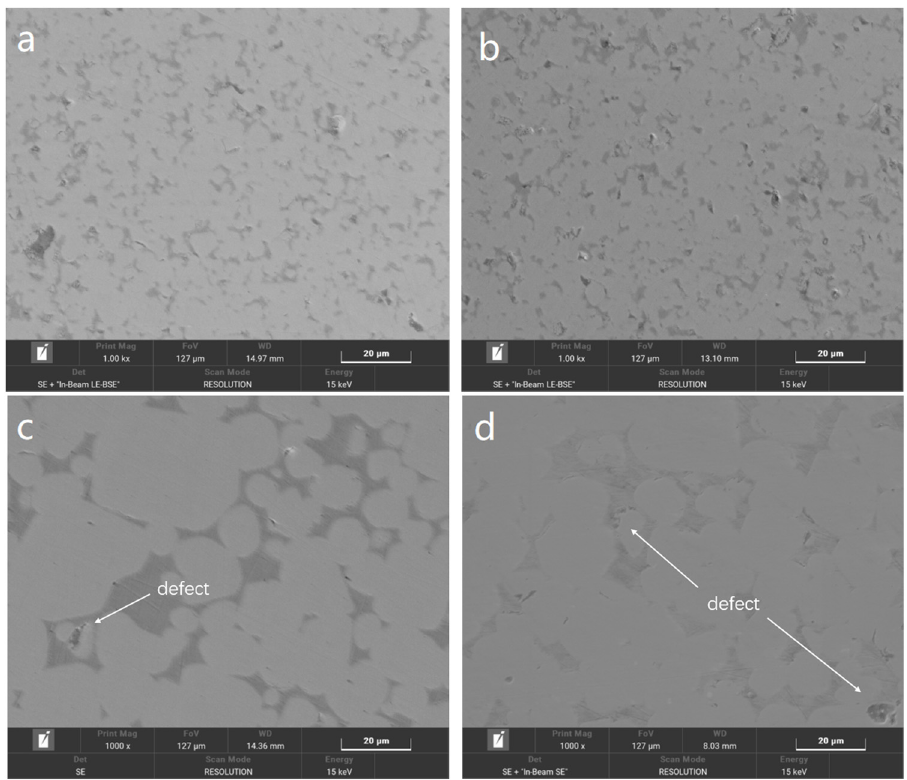
Figure 3: SEM micrograph ( s ) of NbC – 10Ni cermets with di ff erent sintering temperatures ( SE + BSE mode ) : ( a ) 1,360°C, ( b ) 1,390°C, ( c ) 1,420°C, and ( d ) 1,450°C, and dwell time 15 min